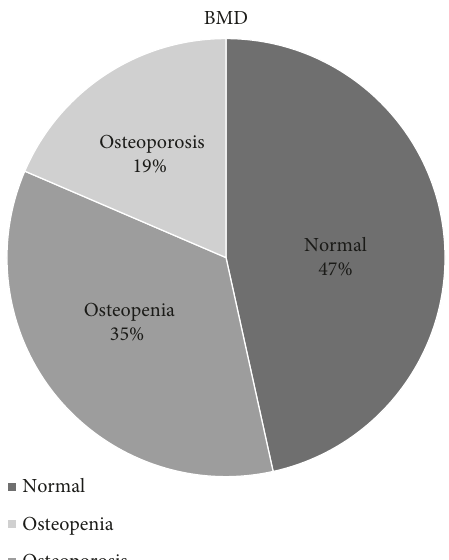
Figure 2: Prevalence of osteoporosis and osteopenia amongst male patients ( n � 507) who underwent CTscans at Kalafong Hospital, South Africa.